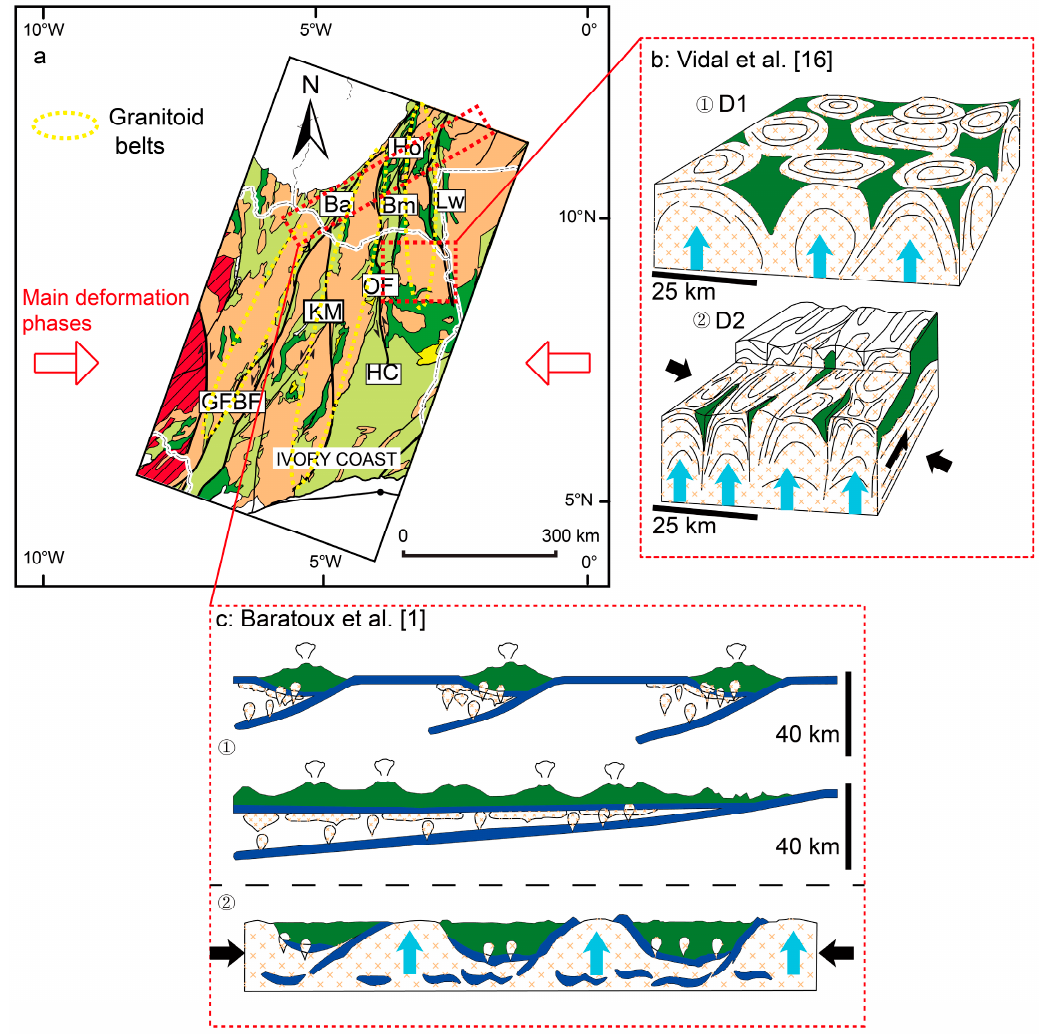
Figure 13. ( a ) Greenstone ‐ granitoid belts, together with two representative tectonic models [1,16]. Yellow dotted ellipses are used to locate granitoid intrusions. Red arrows represent the orientation of main deformation phases in compression during the Eburnean Orogeny. ( b ) “Dorm and basin” structure resulting from upwelling diapirs (due to buoyancy) including two stages (b1, b2), insights from the study in the Nassian domain (after Vidal et al. [16]). (b1) is the self ‐ development of “dome and basin”; (b2) is characterized by coeval ascent of diapirs and shortening. ( c ) The tectonic model accounting for the evolution of deformation in Western Burkina Faso was suggested by Baratoux et al. [1].